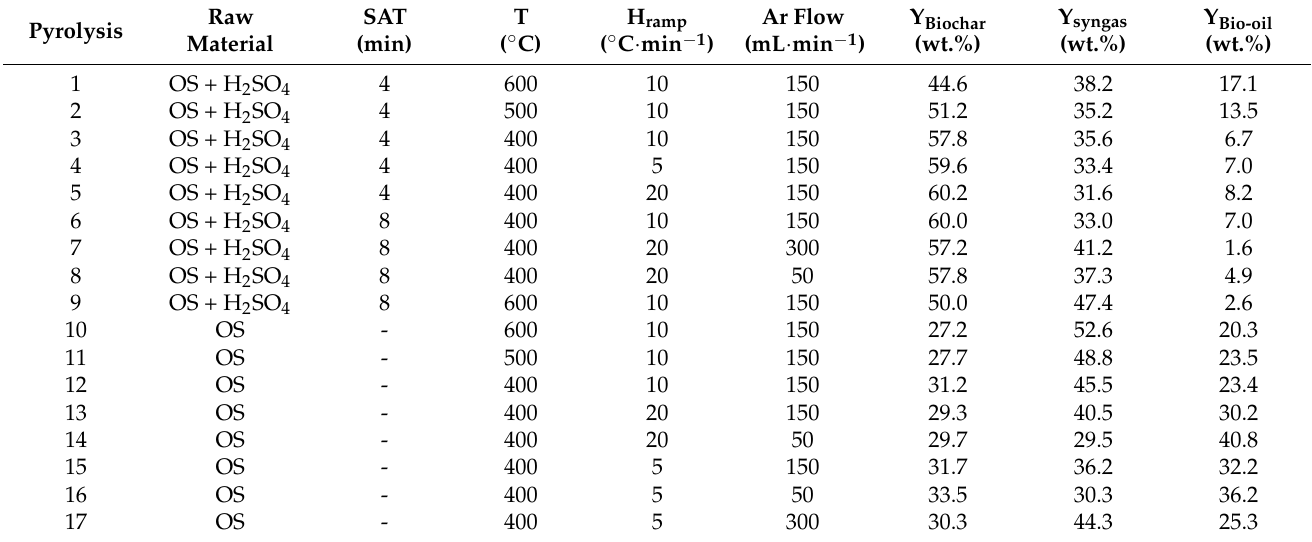
Table 1. Biochar, syngas, and bio-oil yields obtained under different pyrolysis